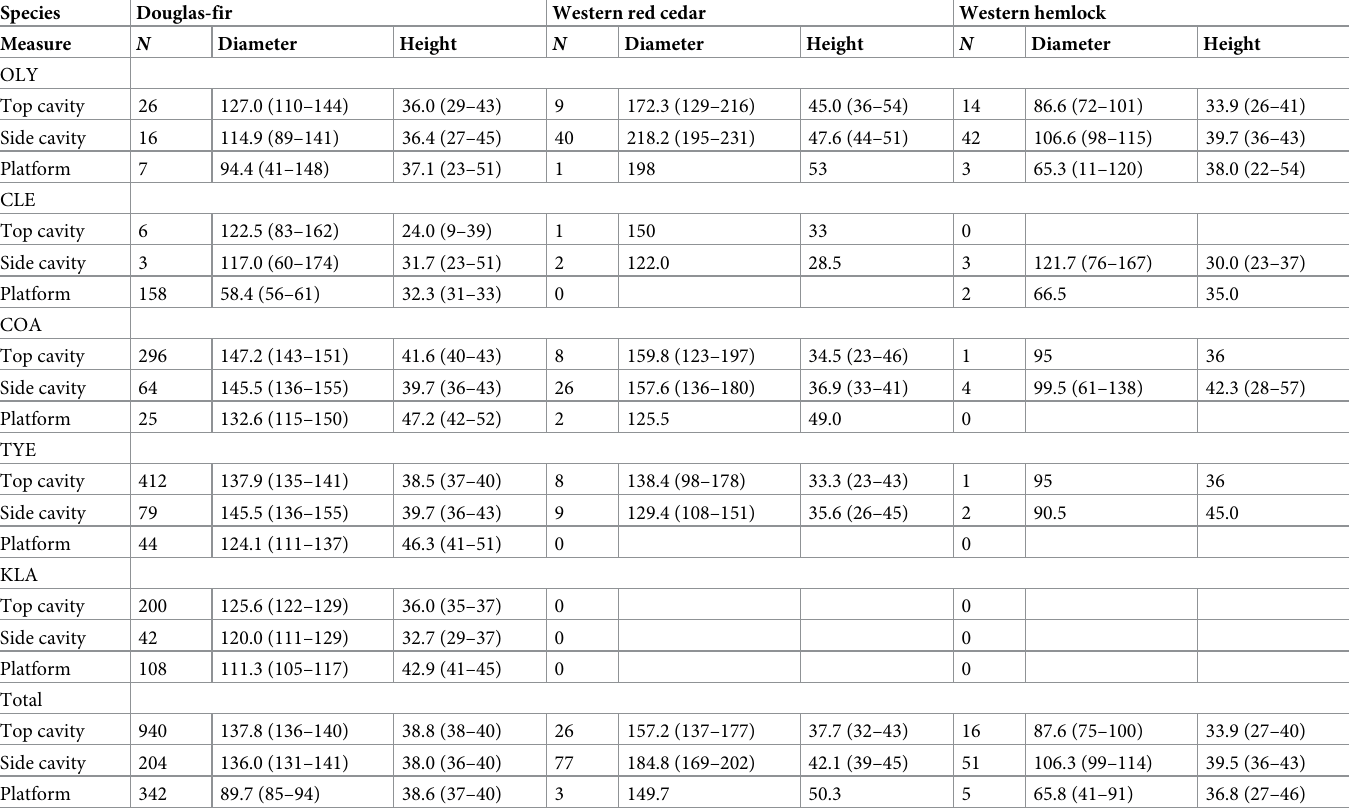
Table 4. Diameter at breast height and total height of nest trees of northern spotted owls by species in Oregon and Washington, USA, subdivided by study area. Diameters ( (cid:22) x cm) and heights ( (cid:22) x m) include 95% confidence intervals (parentheses). Due to small sample size, some CIs are not shown.